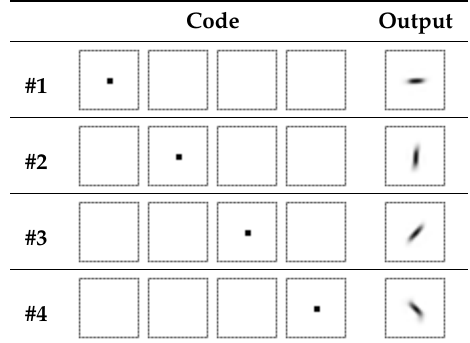
Table 8. MF4 decoder results for synthetic encoding, where only one point is activated. This is intended to show the shape of the visual features that are described by each